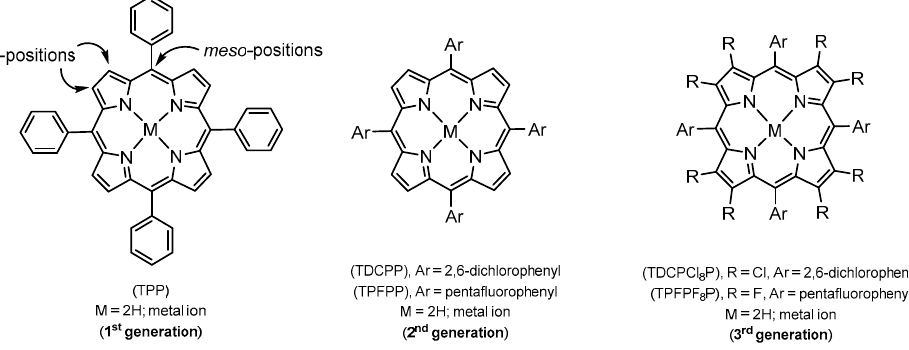
Figure 1. Structures illustrating the so-called first, second and third generation porphyrins [25]. Most of the porphyrinic ligands used in heterogeneous catalysis are based on the 5,10,15,20- tetraarylporphyrins of the first and second generation bearing the adequate functionalities that allow its immobilization on the support. In general, the access to the first and second generation of the free- base 5,10,15,20-tetraarylporphyrins is based on synthetic improvements of the landmark Rothemund reaction. In 1936, Rothemund was able to obtain, for the first time, a series of 5,10,15,20-tetrasubstituted porphyrins from the condensation of aliphatic, aromatic and heterocyclic aldehydes with pyrrole using a mixture of pyridine and methanol, at 145–155 °C in a sealed tube under anaerobic conditions (Scheme Calvin and coworkers [73,74], were the major drawbacks which were partially solved by the aerobic